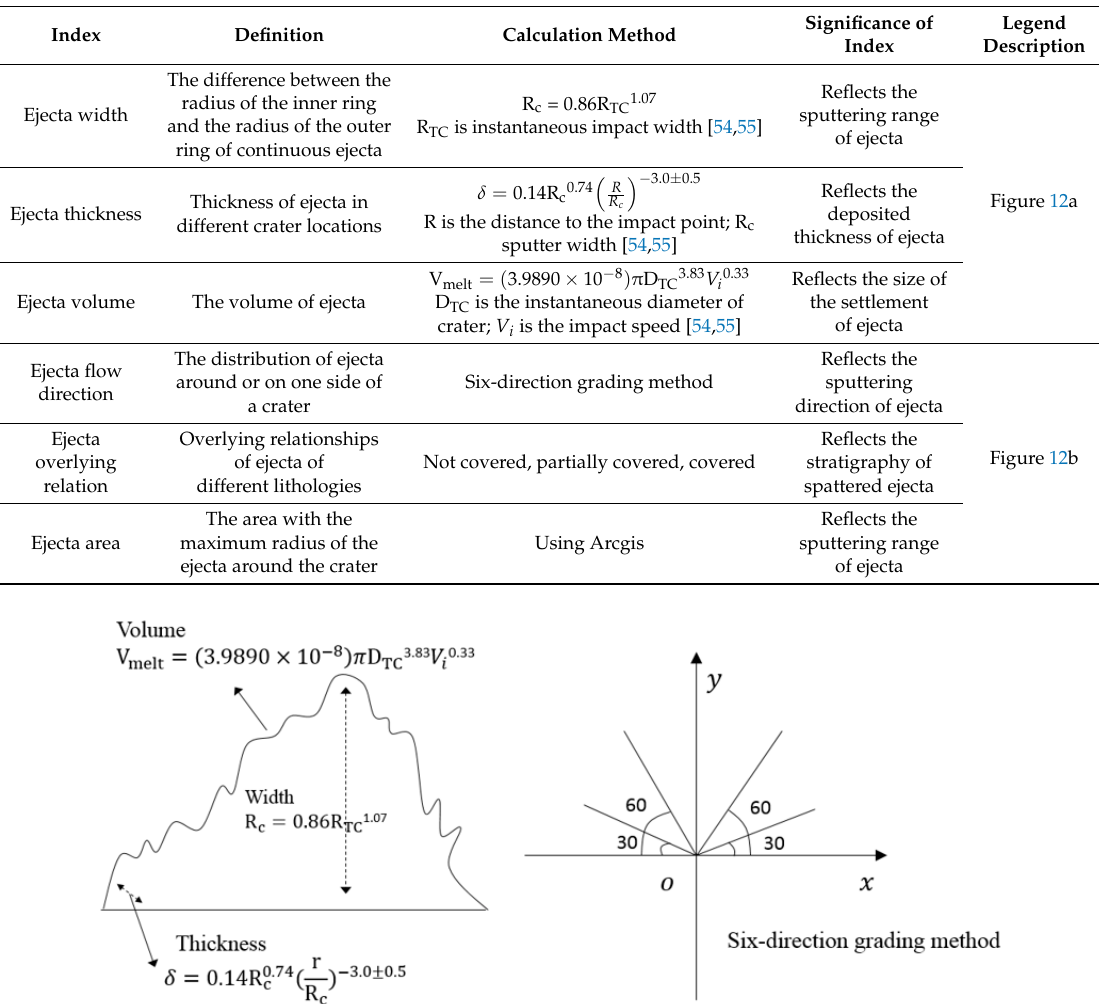
Table 6. Indices for description of ejecta.